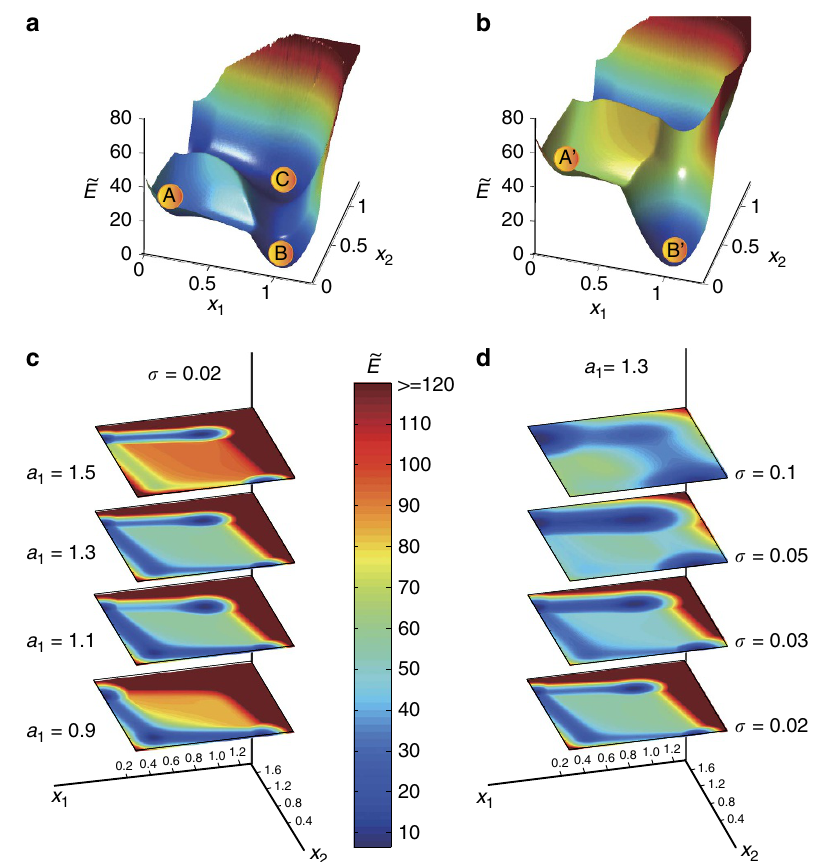
Figure 6 | Illustration of pseudo potential landscape. ‘Pseudo’ potential ~ E of the two-node GRN system ( a ) for a 1 ¼ 1.0 ( D d E 0.3549), s ¼ 0.05 and ( b ) for a 1 ¼ 1.3 ( D d E 0.0549), s ¼ 0.05. Regions of warm and cold colours indicate the states with large and small pseudo energies, respectively. ( c ) For fixed s ¼ 0.02, two-dimensional representation of ~ E for a number of values of a 1 . ( d ) For fixed a 1 ¼ 1.3, two-dimensional representation of ~ E for a number of values of s